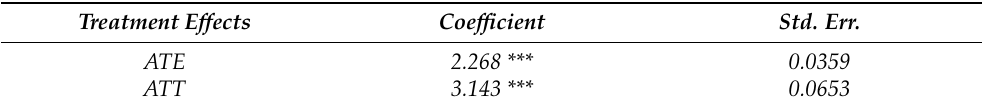
Table 5. Treatment effects for the adoption of climate change adaptation strategies on household food security of rice farmers.